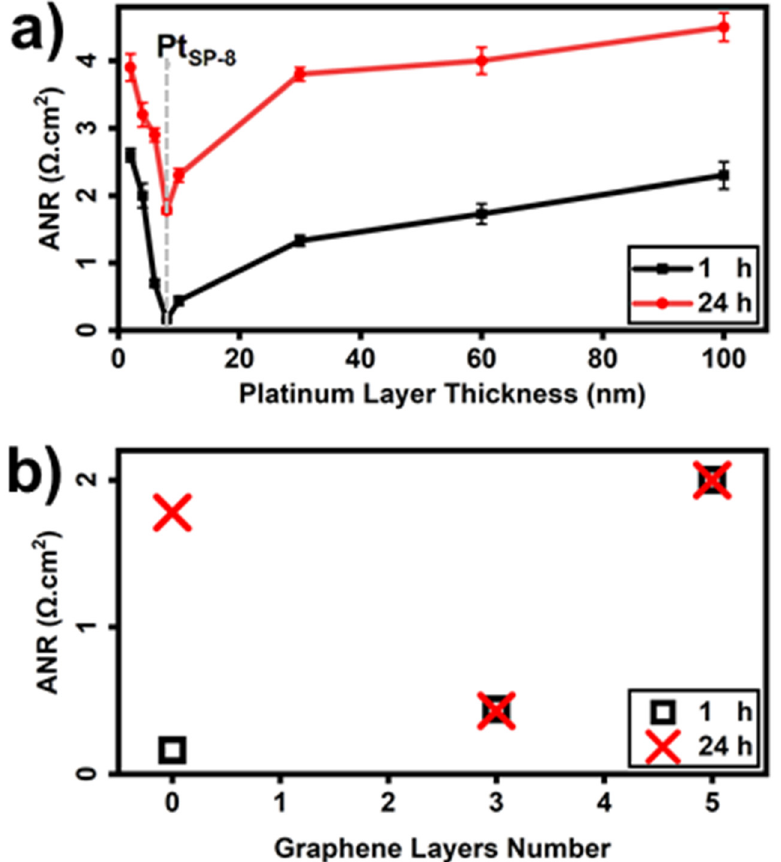
Figure 4. Measurements of the ANR were obtained by impedance spectroscopy under anode conditions. ( a ) Dependency of the ANR with the platinum film thickness of graphene-free electrodes. The platinum was deposited using magnetron sputtering. ( b ) Dependency of the ANR of Pt SP-8 electrodes in the presence of graphene layers with varying thicknesses. The graphene was transferred to the CDP surface before platinum deposition via magnetron sputtering using PMMA and iron chloride in hydrochloric acid as an